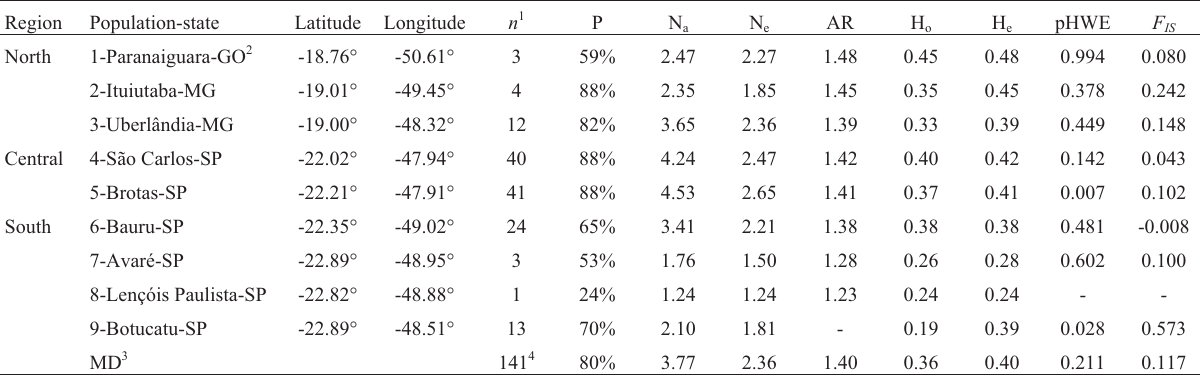
Table 1 - Basic characteristics of the P. moratoi study populations, grouped by geographic region (see Figure 1) and levels of intrapopulation genetic di- versity.